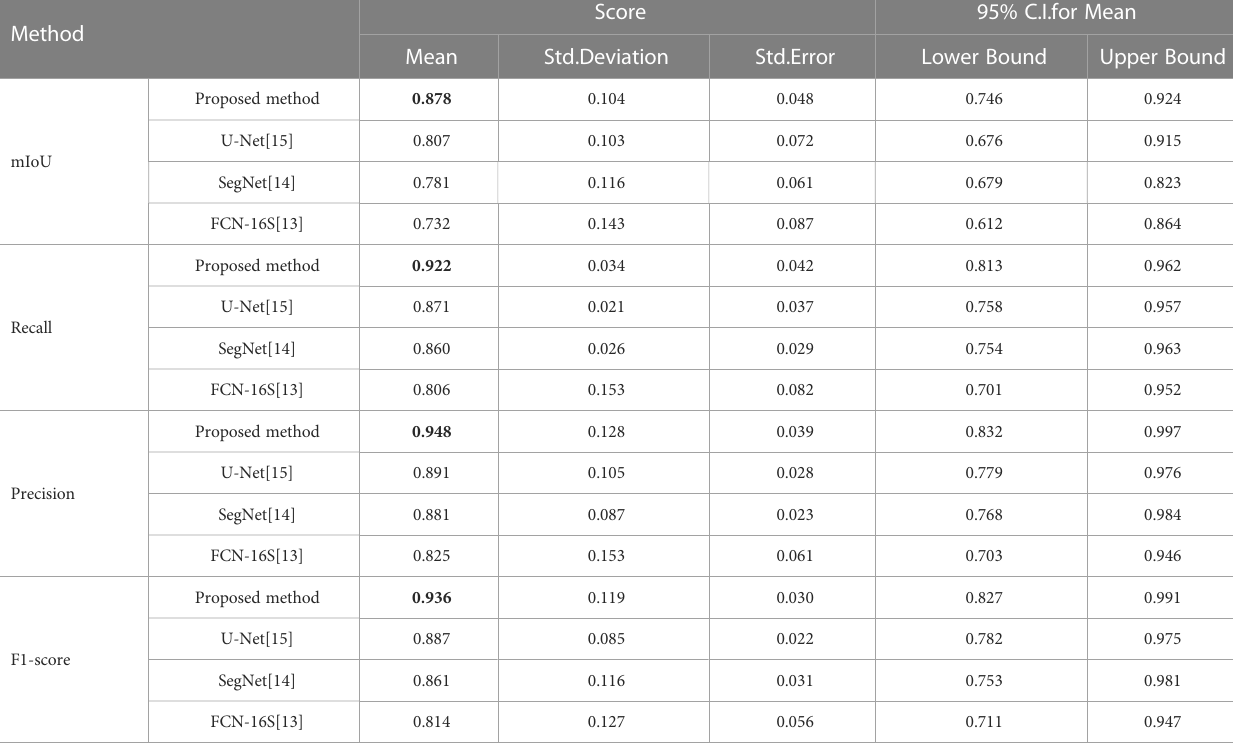
TABLE 4 Quantitative evaluation of the proposed method and the baseline approaches in the segmentation of CT images of lung nodules.